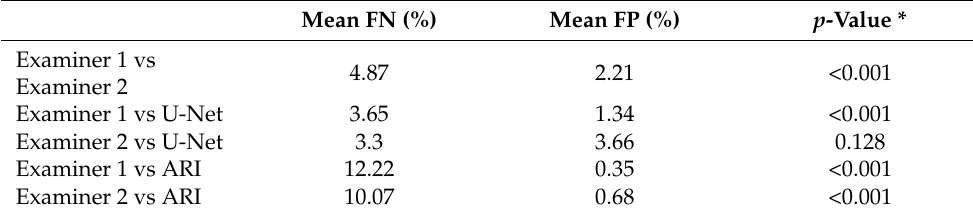
Figure 4. Multiple comparisons using the Jaccard index ( A ) and DSC ( B ). Results of the Jaccard index ( A ) and DSC ( B ). Comparing each 5 similarities coefficient of extraction methods, significant differences ( p < 0.001) were found for all of those without a p -value listed. For similarities, the results between examiner 1 and the U-Net are significantly better than those between the manual methods (examiner 1 and 2) ( p < 0.001), and the results between examiner 2 and the U-Net are not significantly different from those of the manual methods ( p = 1.00). The Bonferroni correction was used to adjust the p -value. Table 4. Significant differences between the false negatives (FN) and false positives